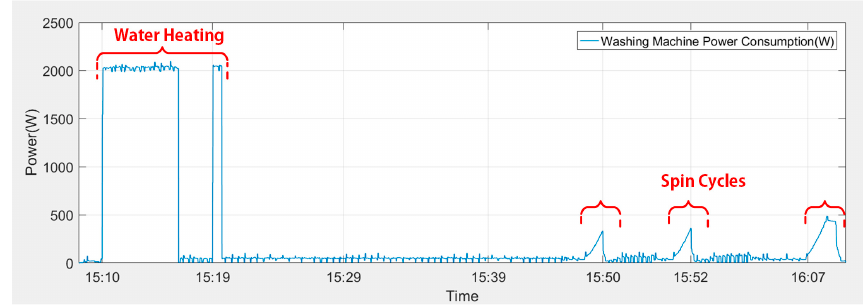
Figure 7. The power consumption of the washing machine for the mixed washing program at 30 °C.